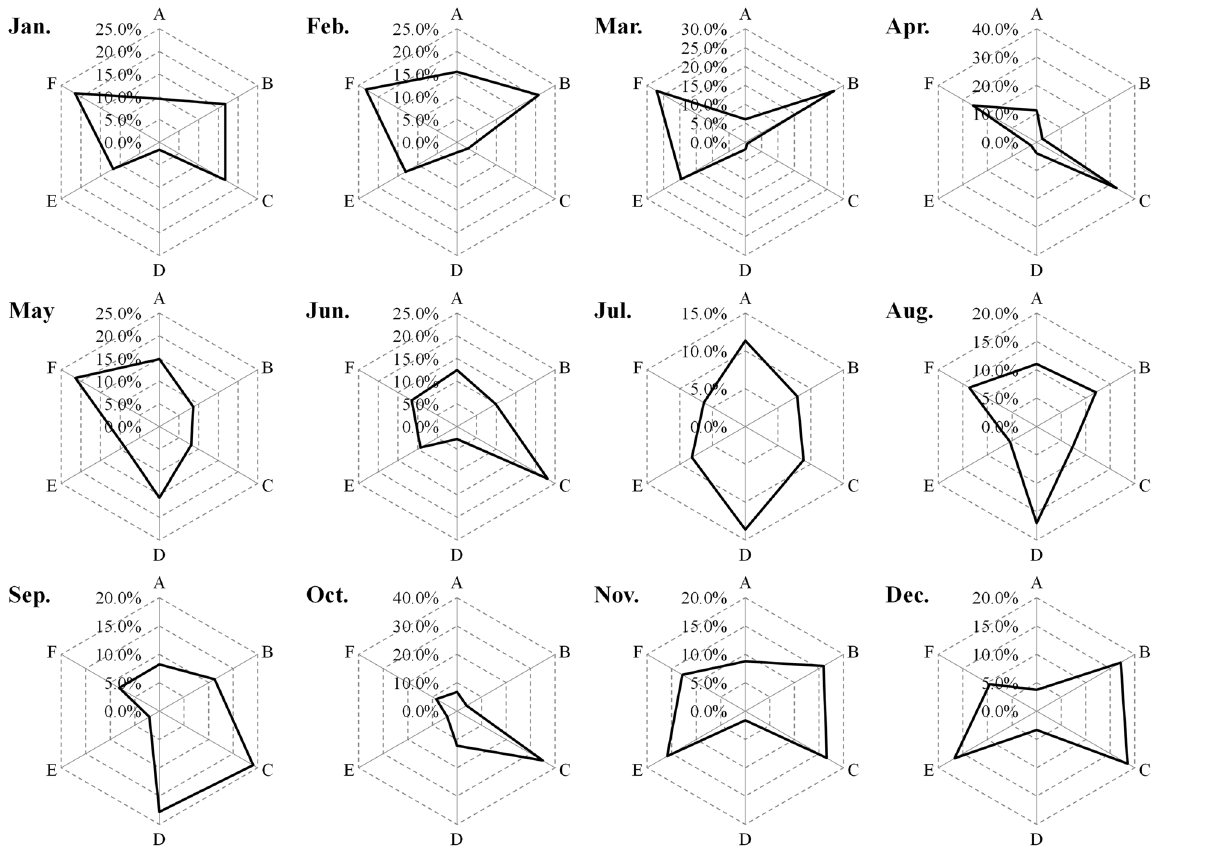
Figure 6. Entropy weight analysis of the key indices of the internal water–sediment–electricity system at the monthly scale in the current situation (The time period is